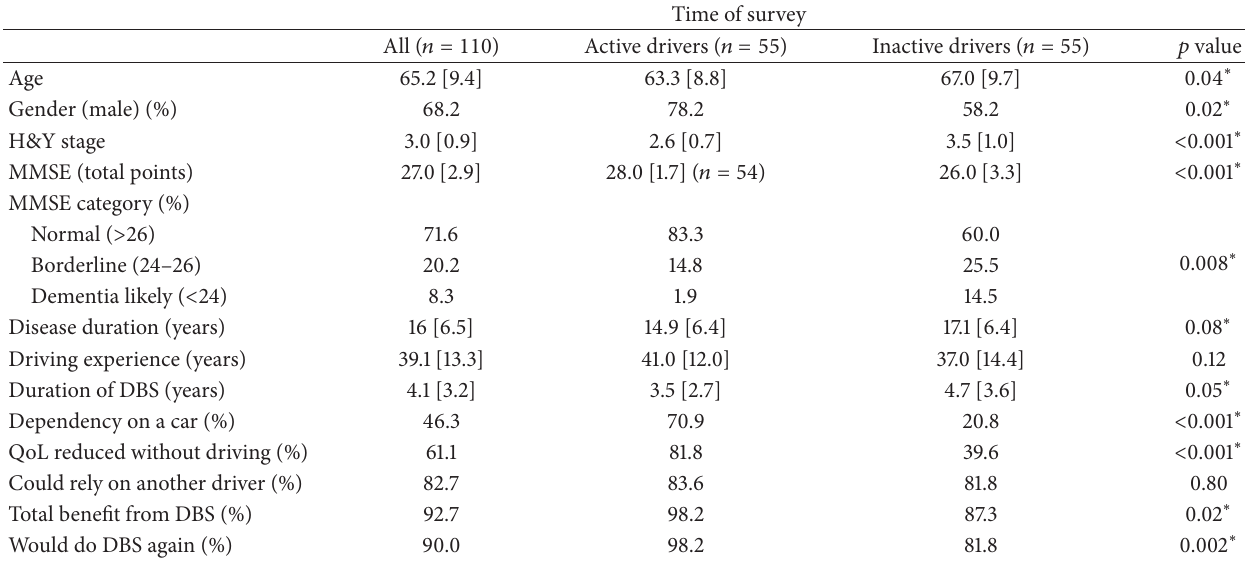
Table 1: The table shows patient characteristics of drivers at time of survey. Data are shown as means with standard deviation [ SD ] . Significant different frequencies between active and inactive drivers are labeled with an asterix ( ∗ ). “H&Y”: Hoehn and Yahr; “QoL”: quality of